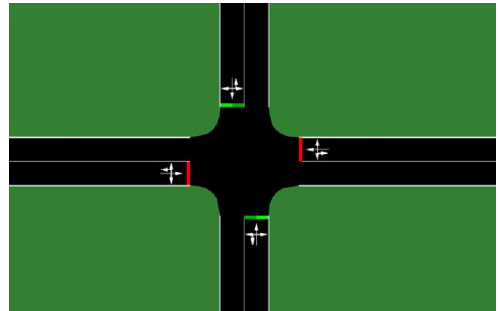
Figure 8. A simple intersection scenario in the SUMO, used in the experiments.